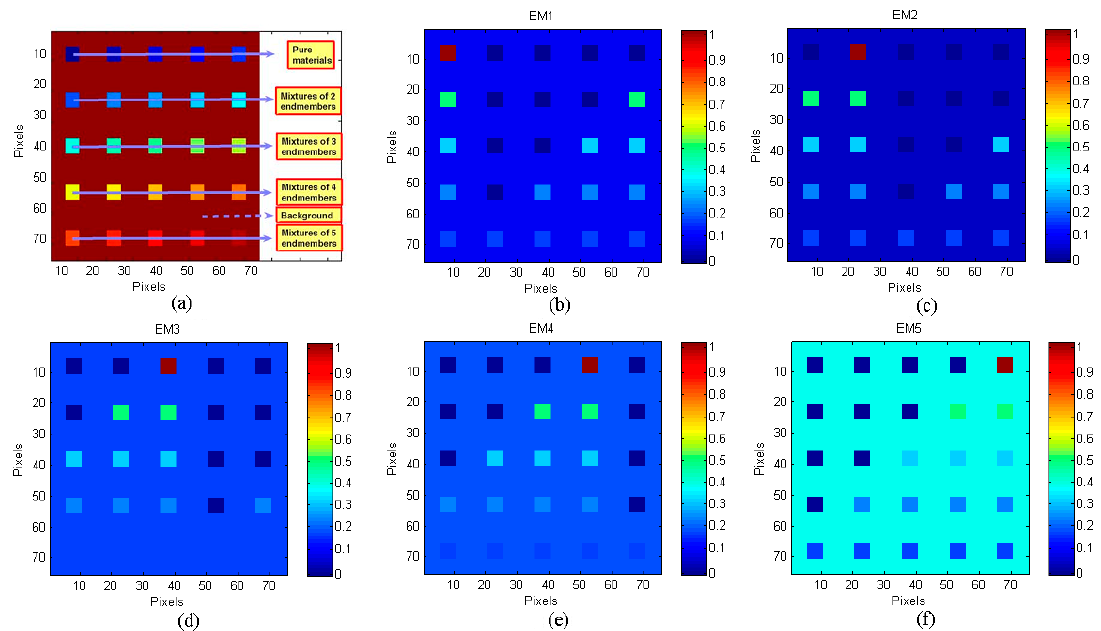
Figure 3. True fractional abundances of endmembers in the simulated data cube 1 (DC1): ( a ) simulated image; ( b ) the true abundance of endmember 1; ( c ) the true abundance of endmember 2; ( d ) the true abundance of endmember 3; ( e ) the true abundance of endmember 4; and ( f ) the true abundance of endmember 5.